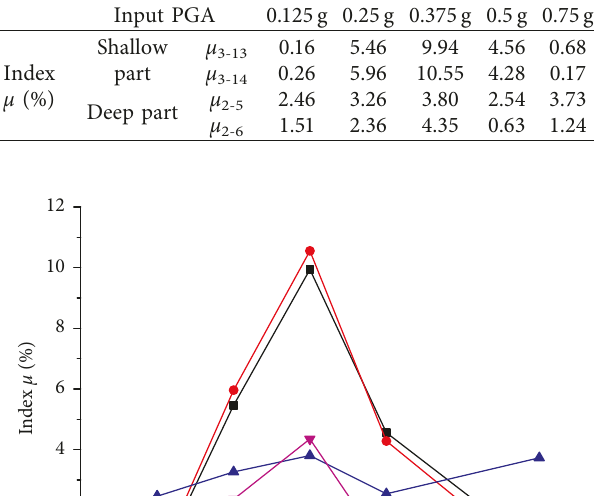
Table 5: Index of boundary effect in the shaking table test.